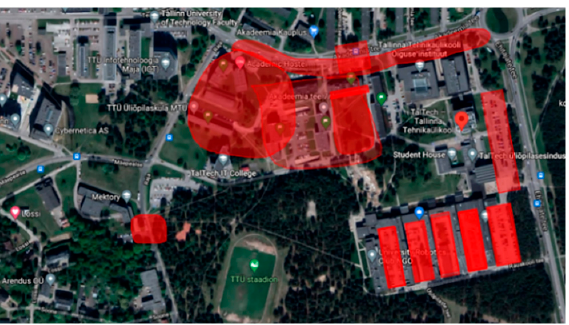
Figure 6. Taltech campus map with colored less attractive areas by the interviewees [48].